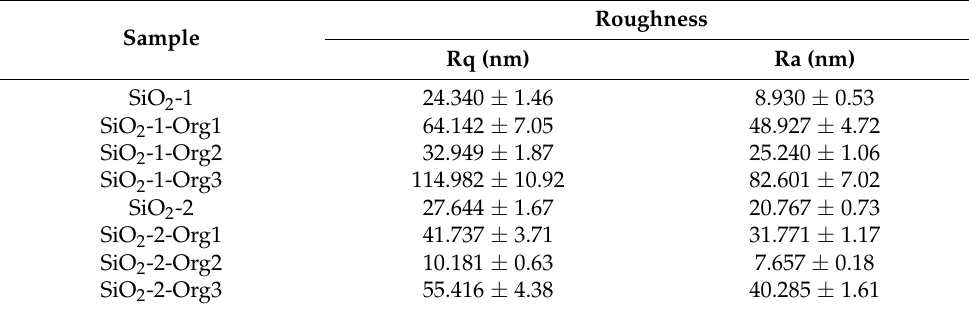
Table 3. Roughness values of hybrid silica coatings at various TEOS/DDTES